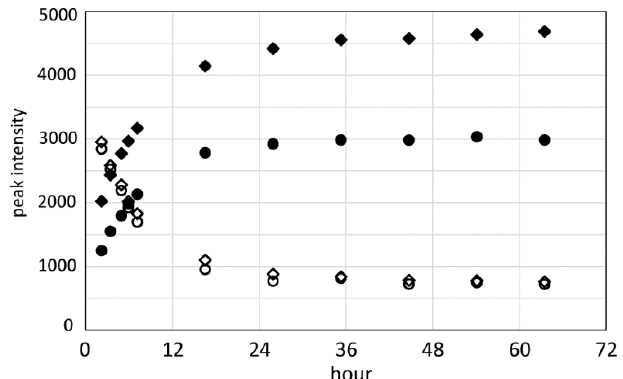
Figure 7. The plot of peak intensity for the CαH and CβH 2 protons of unformylated and formylated Ser residues over time after the dissolution of RSP in FA. (● formylated Hα, ◆ formylated Hβ, 〇 unformylated Hα, ◇ unformylated Hβ)